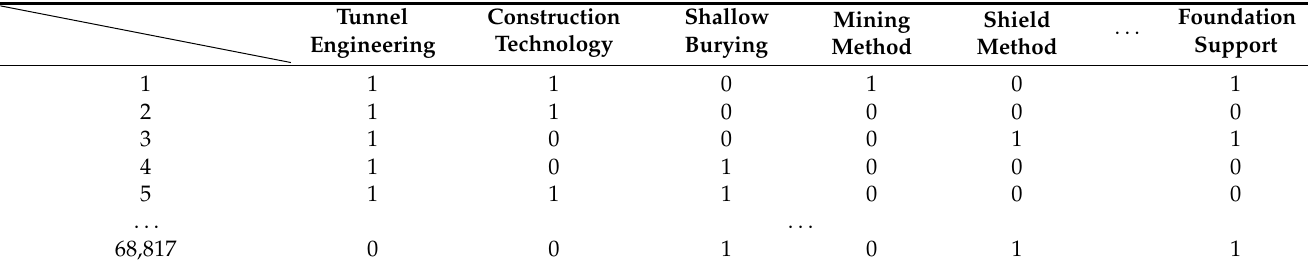
Table 1. Binary term–document